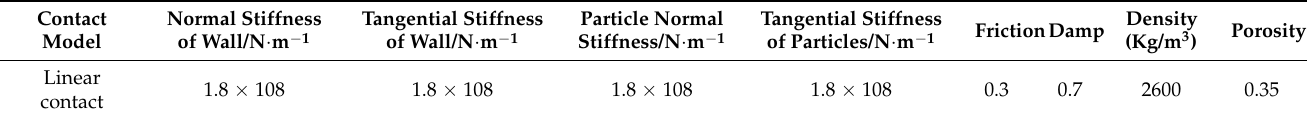
Figure 6. Numerical simulation model and results of consolidation experiment; ( a ) Numerical simulation model of consolidation experiment; ( b ) Numerical simulation results of consolidation experiment (x-axis shows the force applied, y-axis shows the amount of compaction). Table 1. Microscopic parameters of aeolian sand [30].